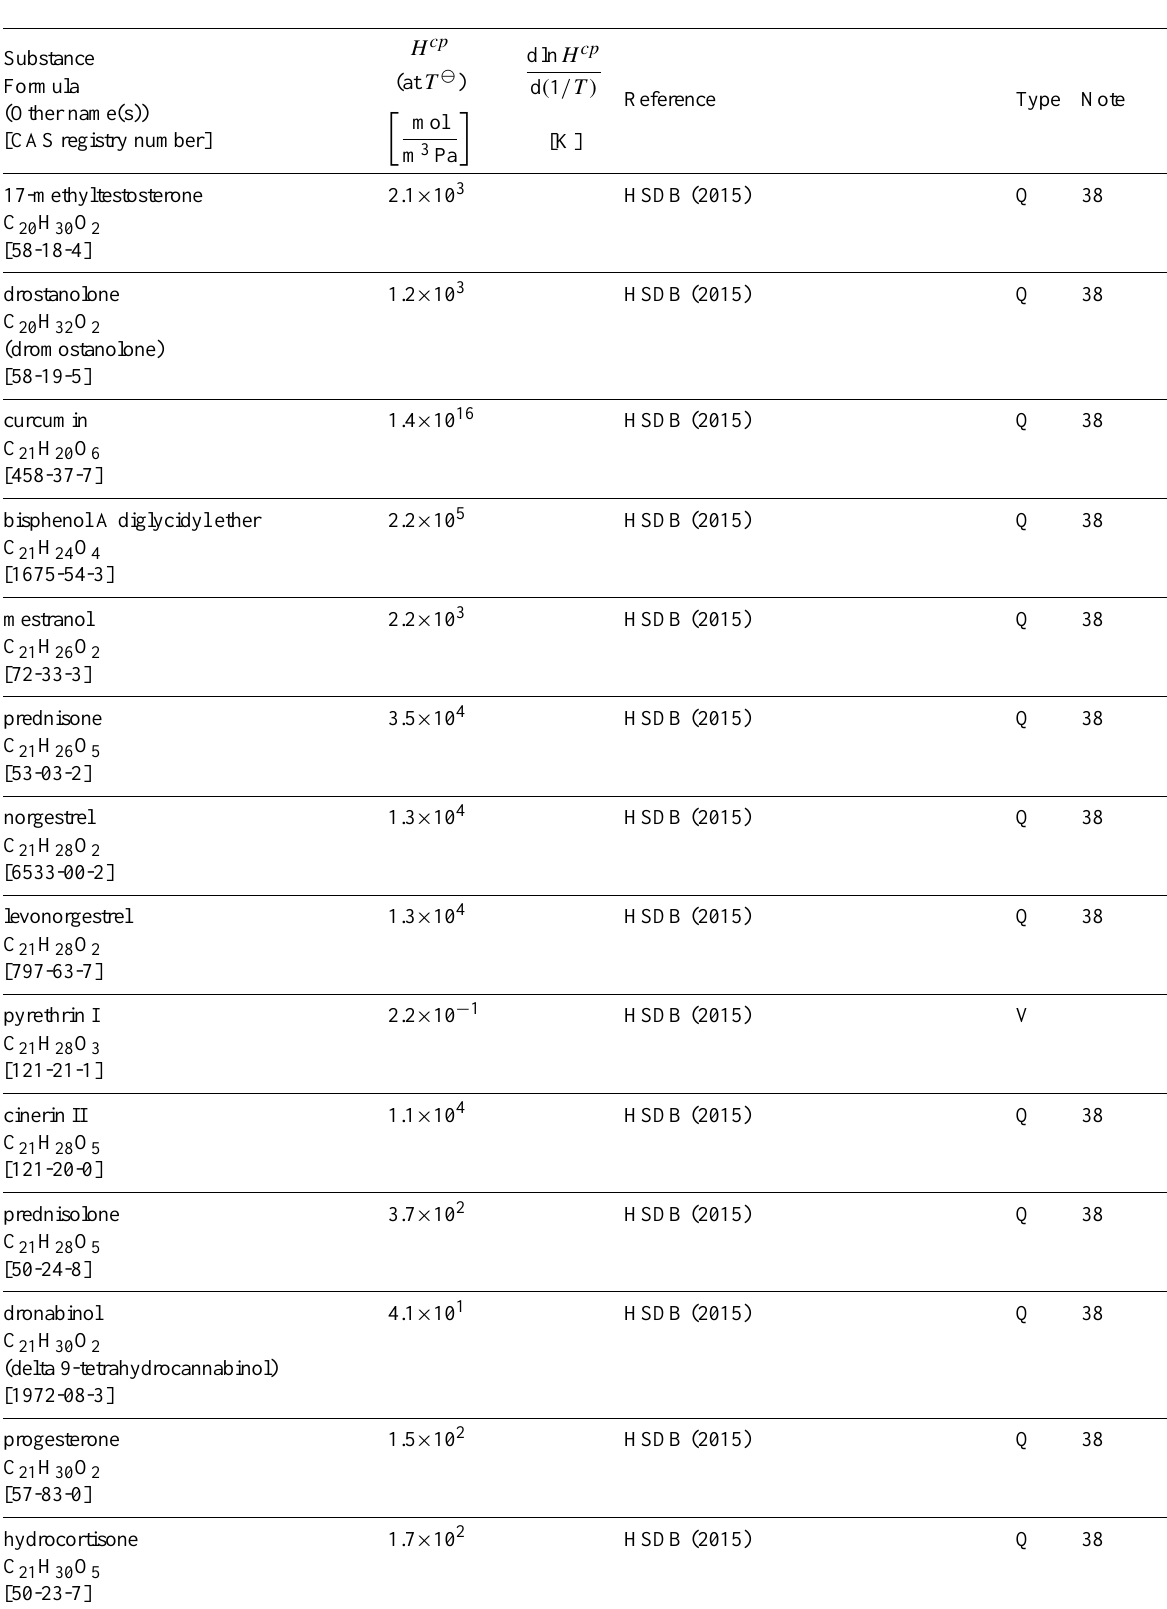
Table 6: Henry’s law constants for water as solvent